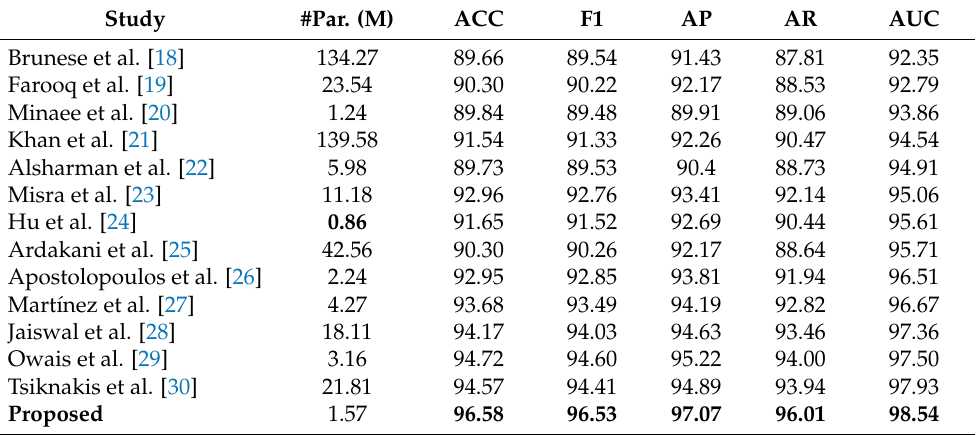
Table 4. Comparative performance analysis of DSS-Net with various state-of-the-art methods. (“#: The number of”). #Par.